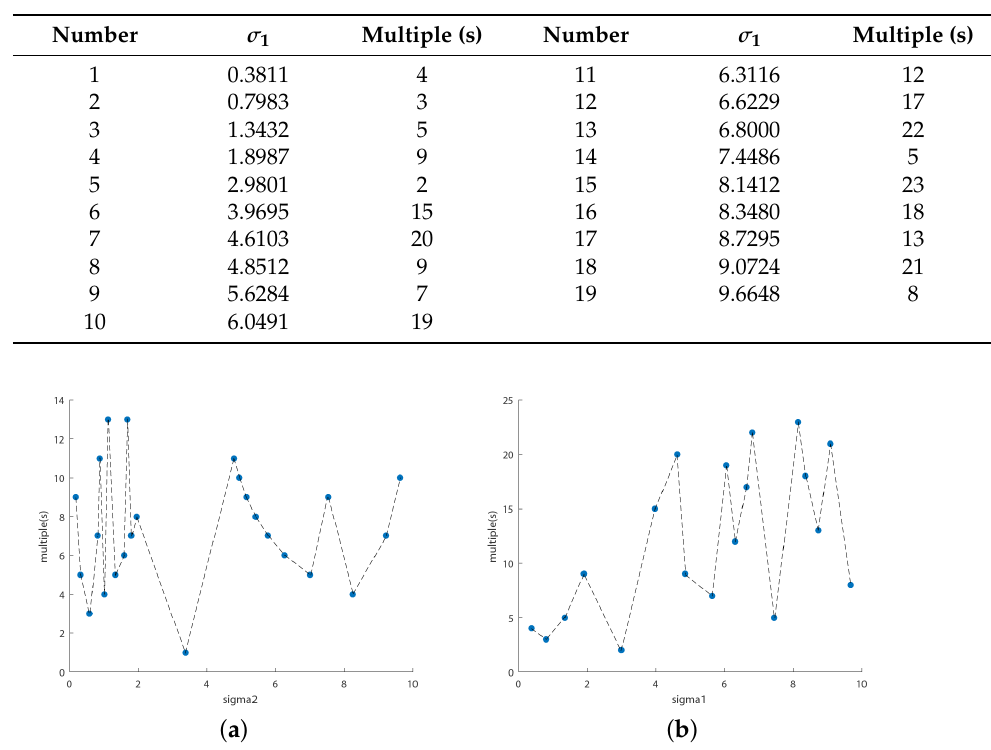
Table 2. Multiples of periodic motion with parameter σ 1 .